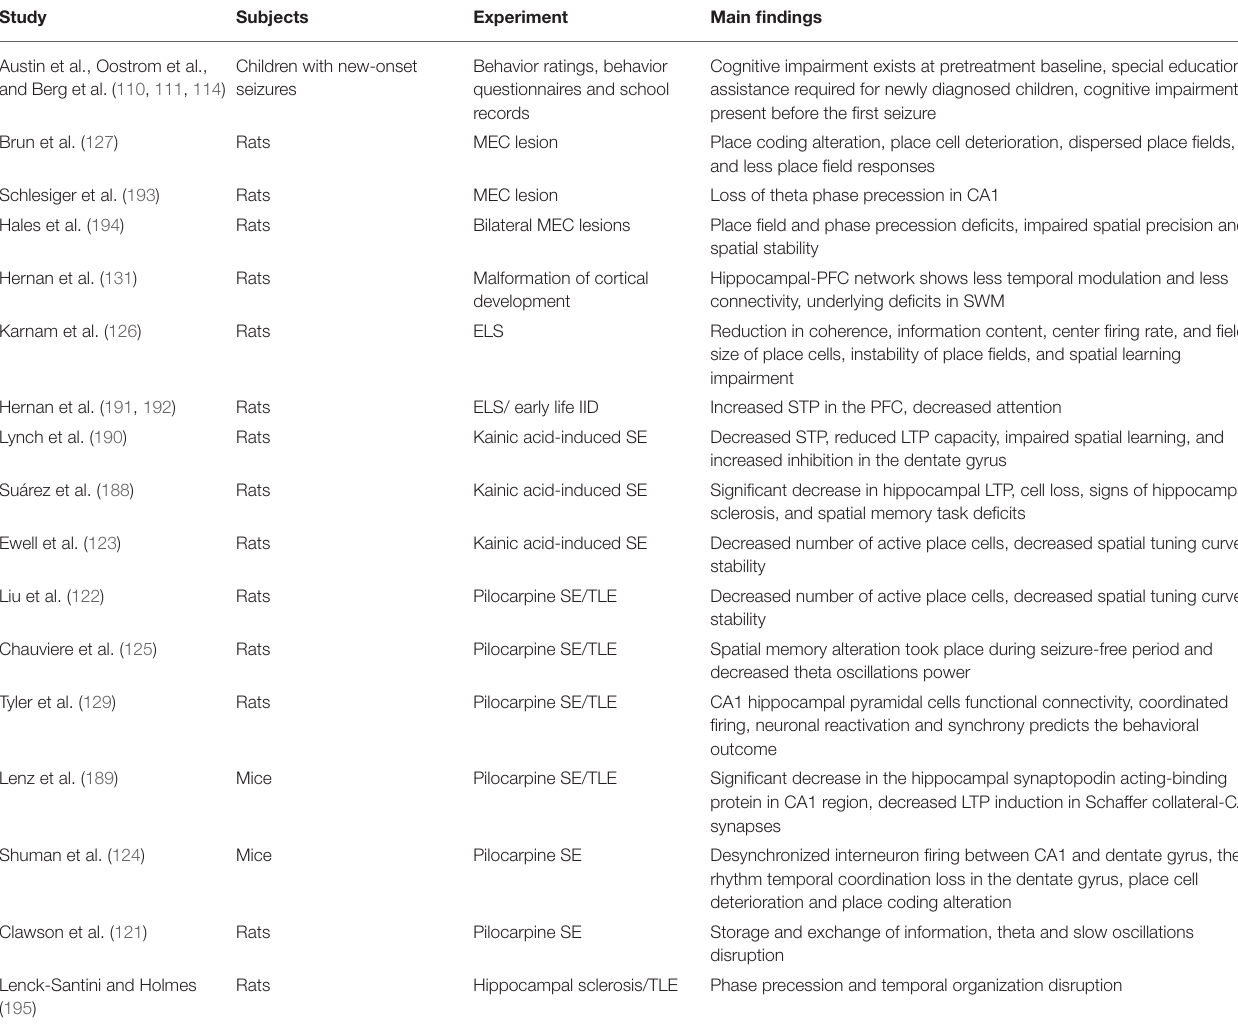
TABLE 3 | Overview of cited preclinical